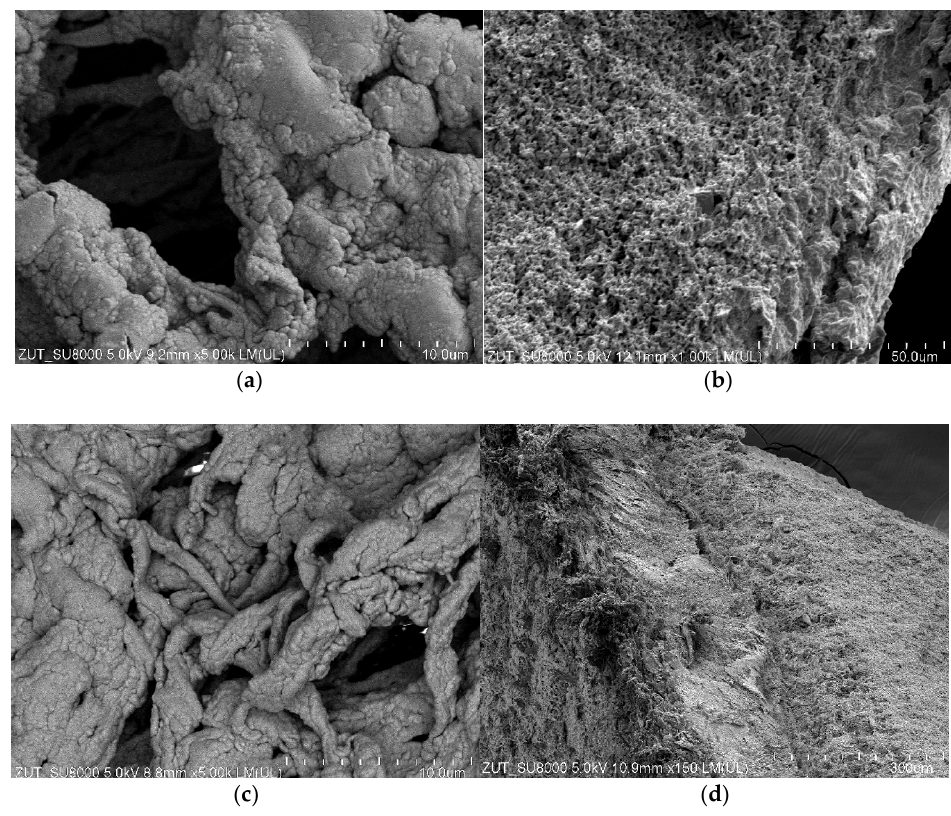
Figure 17. SEM images of the membranes used. Module SMD ‐ S6 ‐ 2: ( a ) external surface; ( b ) wall cross ‐ section. Module SMD ‐ V8: ( c ) external surface; ( d ) wall cross ‐ section (external edge).